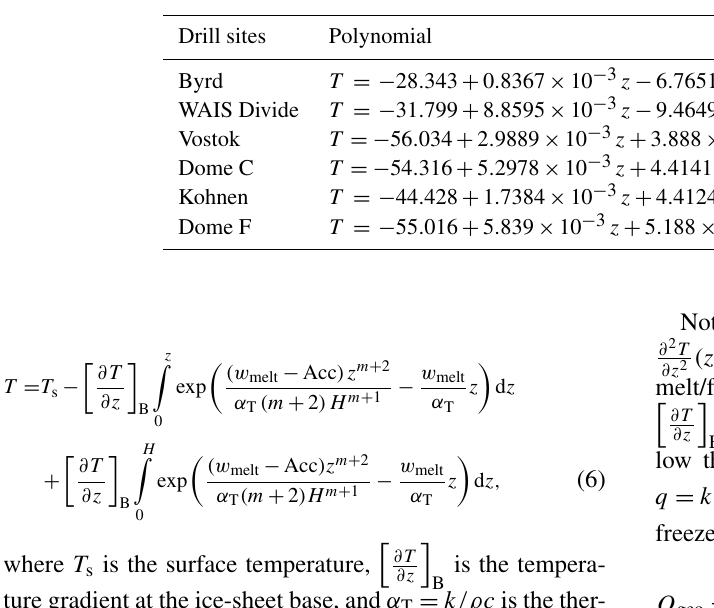
Table 3. Polynomial approximations of borehole temperature T ( ◦ C) as a function of true vertical depth z and correlation